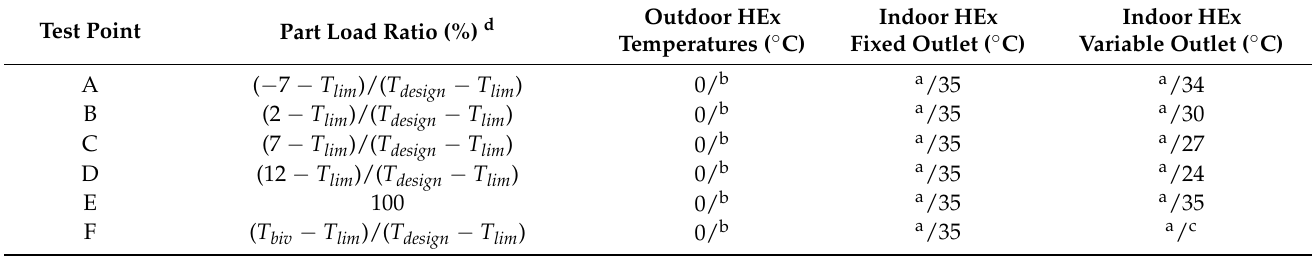
Table 2. Space heating test conditions at part-load of a brine-to-liquid heat pump for low-temperature applications under average climate conditions